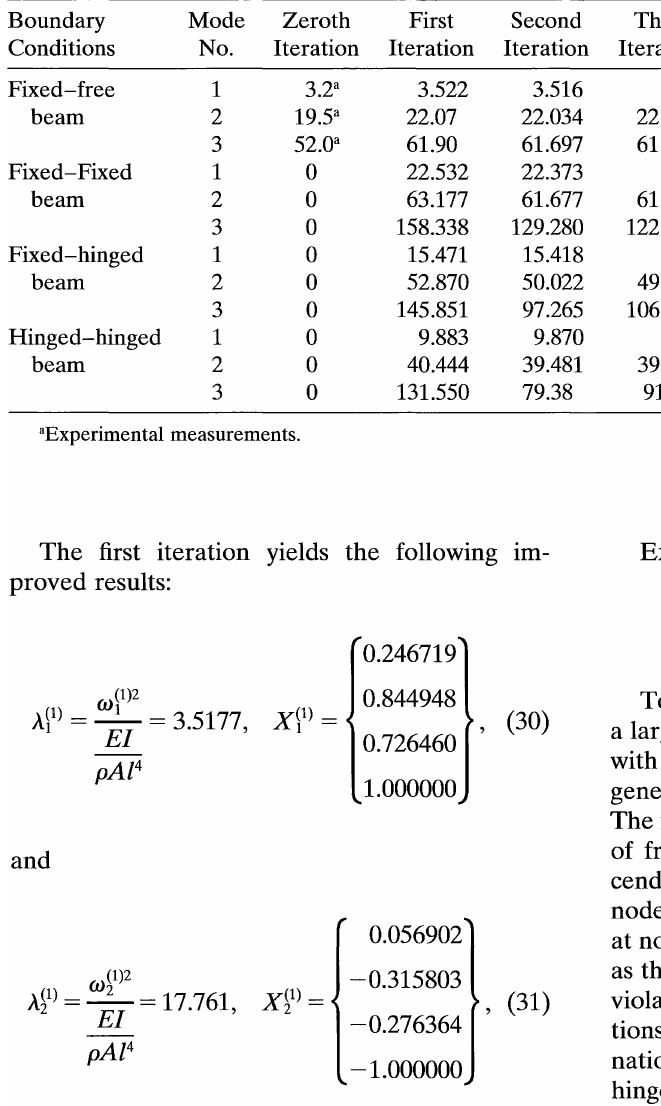
Table 1. First Three Natural Frequencies of Beams with Differeut Boundary Conditions